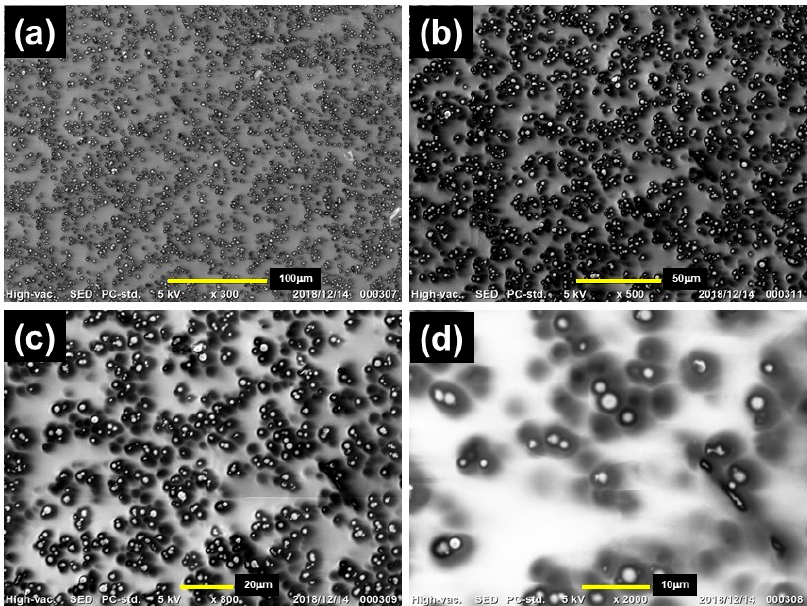
Figure 2. SEM photographs of a cross-section of the magnetic elastomer used in the CT observations at various magnifications; ( a ) × 300, ( b ) × 500, ( c ) × 800, ( d ) × 2000 (CI 70 wt%, DOP 70 wt%).